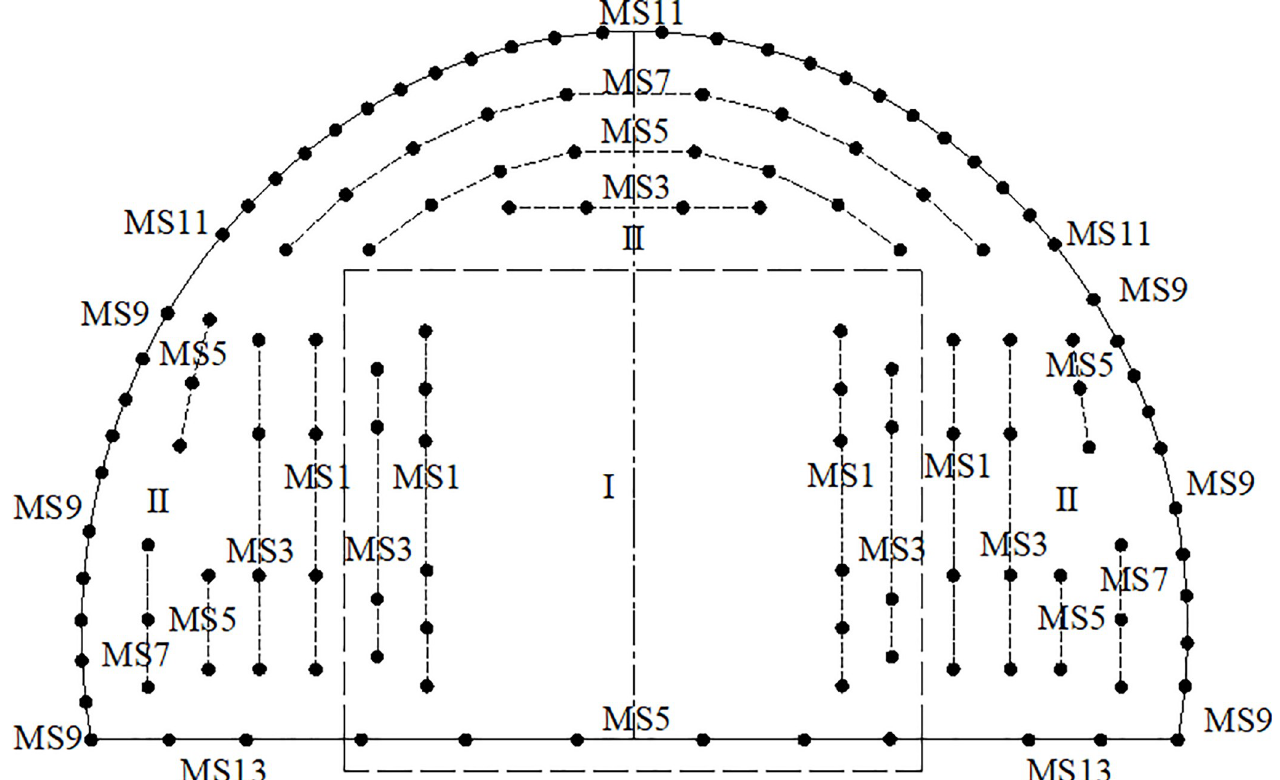
Fig 5. Layout of the blast-holes and the initiation times of non-electric